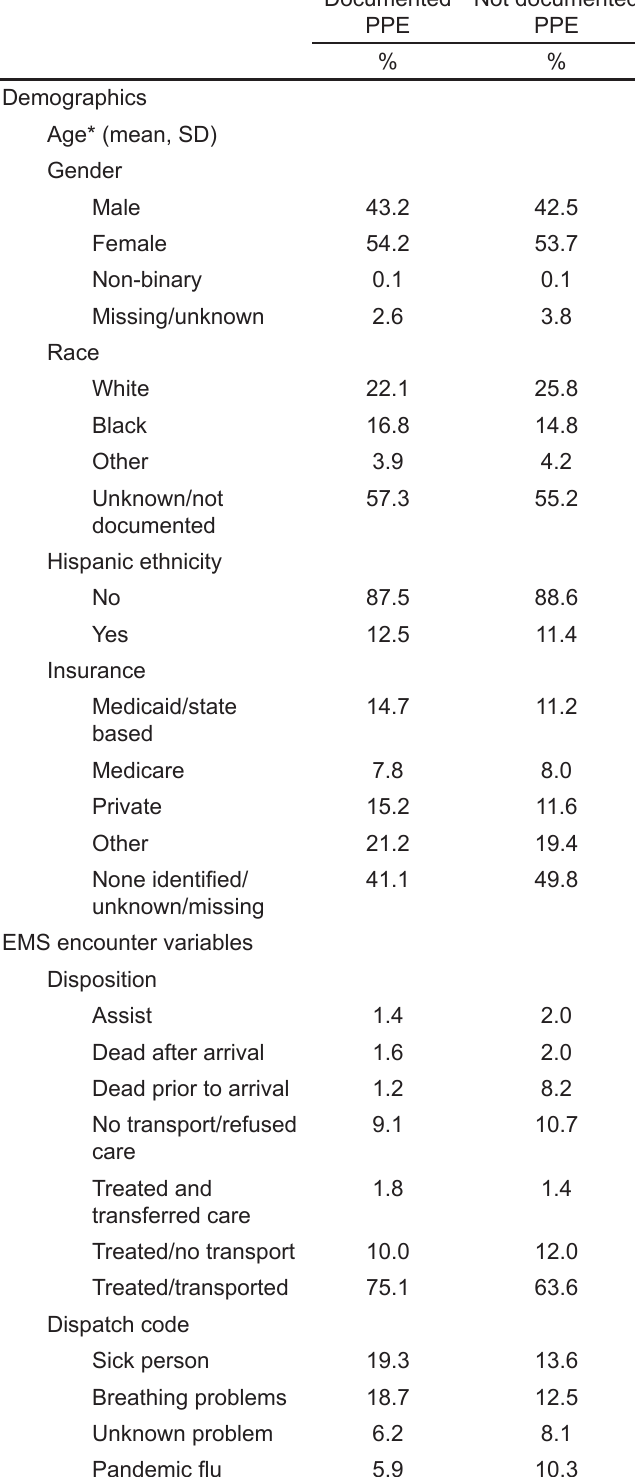
Table 4. Patient- and emergency medical service-encounter covariates by personal protective equipment documentation status (n =